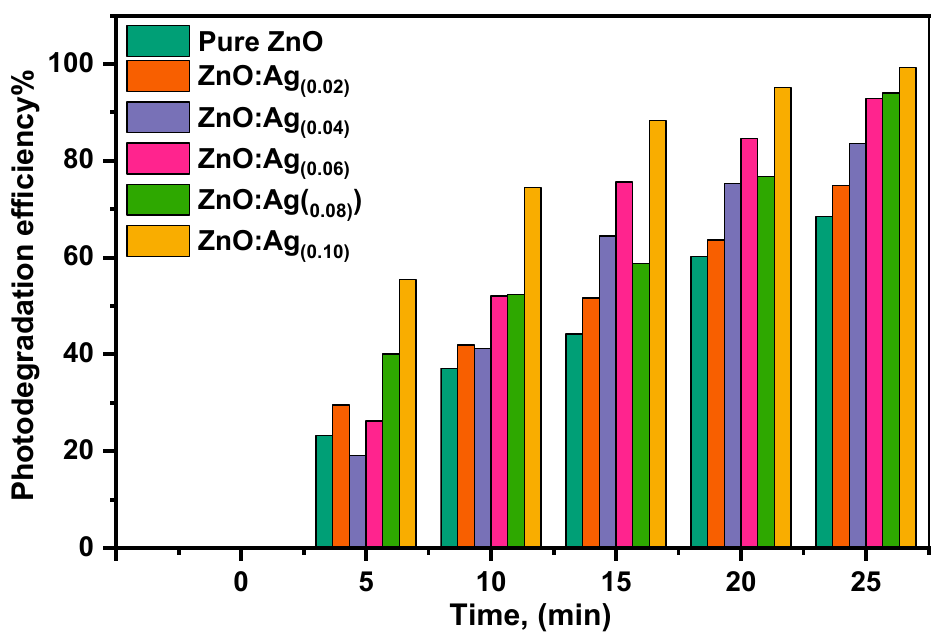
Figure 10. Percentage of MB dye degradation at different times and varying photocatalysts. The rate of dye degradation was calculated using photocatalytic kinetics. Figure 11 shows the plot of C / C o against time